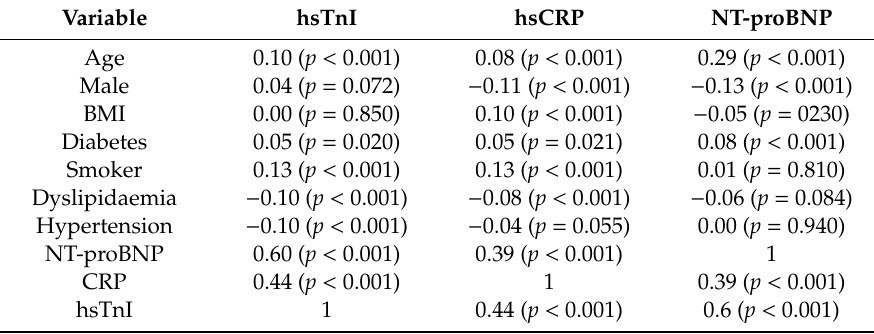
Table 2. Spearman correlations of selected variables with hsTnI, hsCRP, and NT-proBNP.